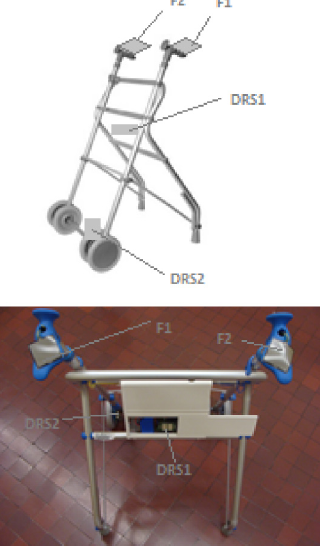
Figure 4. Smart walker architecture and prototype (DRS1, DRS2 = Doppler radar sensors; F1, F2 = piezoresistive force sensors).